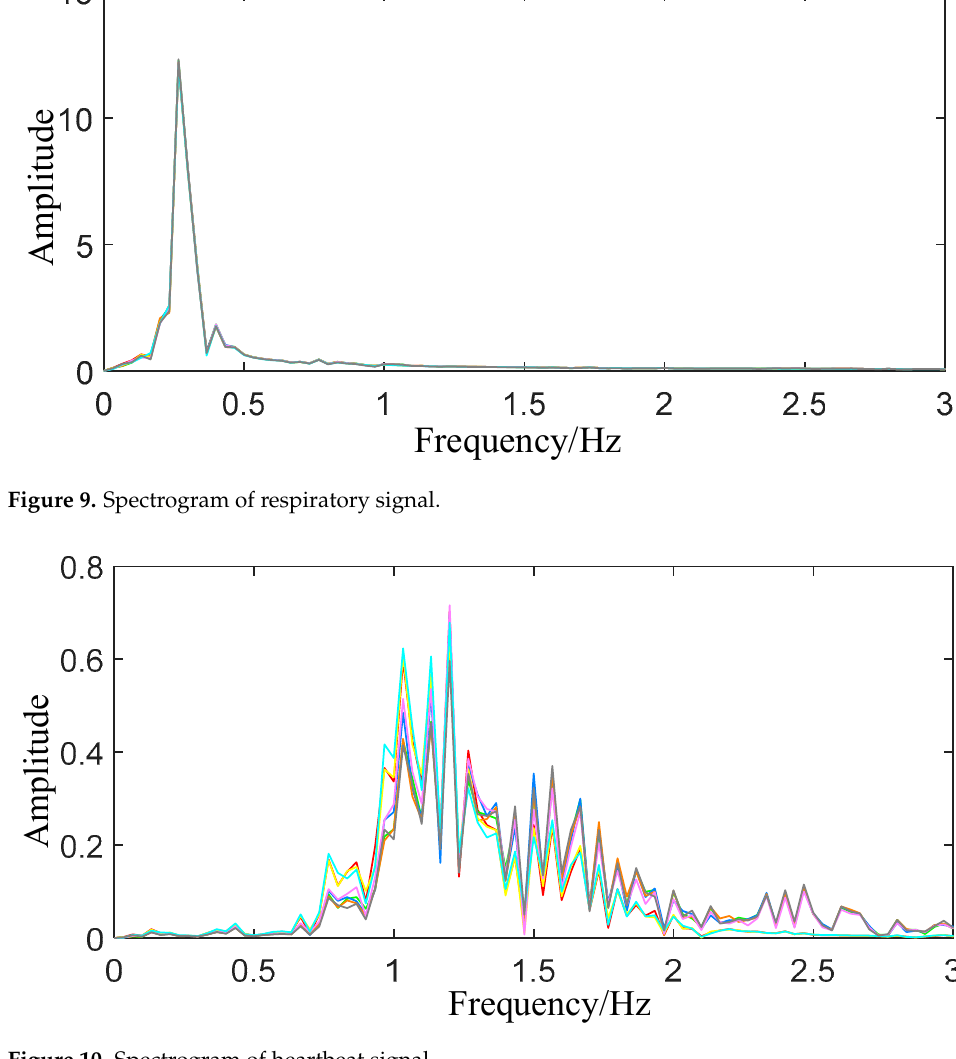
Figure 10. Spectrogram of heartbeat signal.